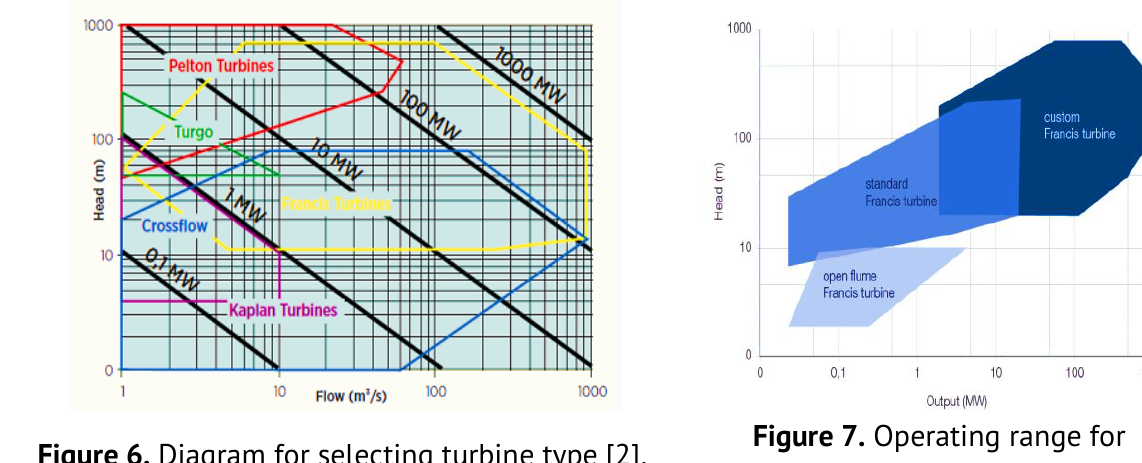
Figure 6. Diagram for selecting turbine type [2].